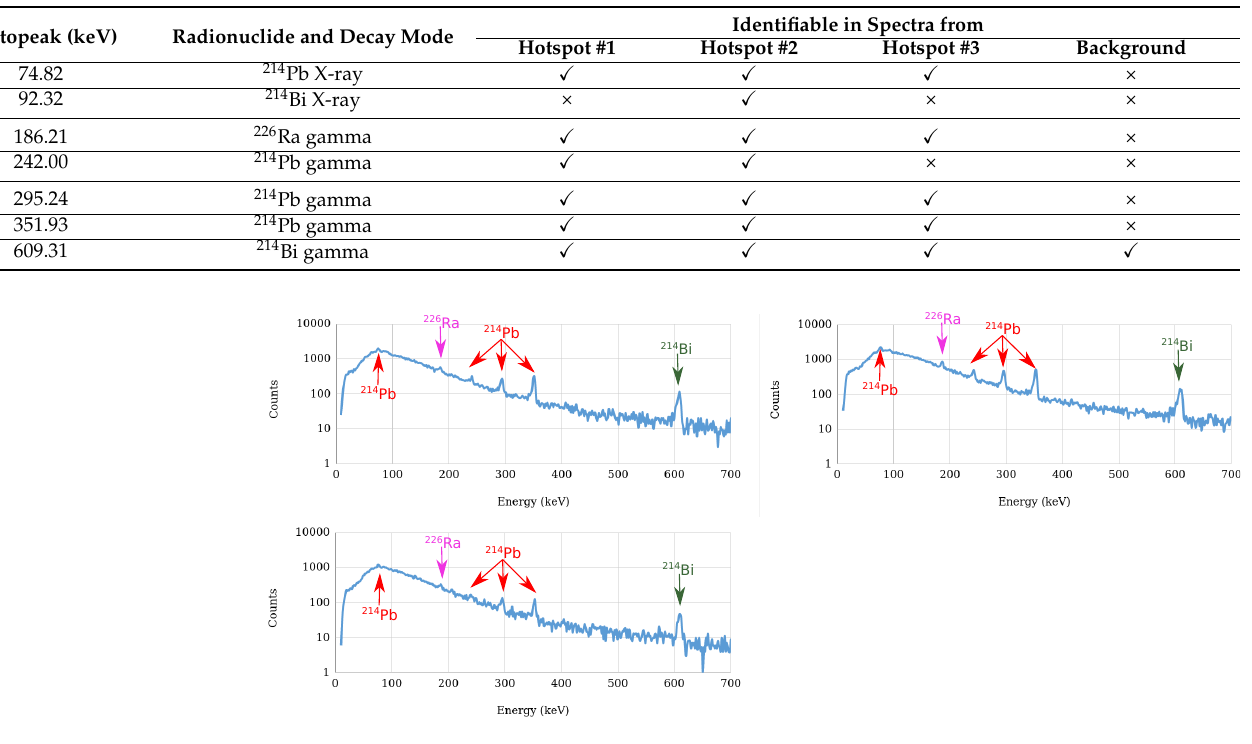
Table 2. Characteristics of the photopeaks identified in the spectra acquired from the three selected hotspots and back- ground level.